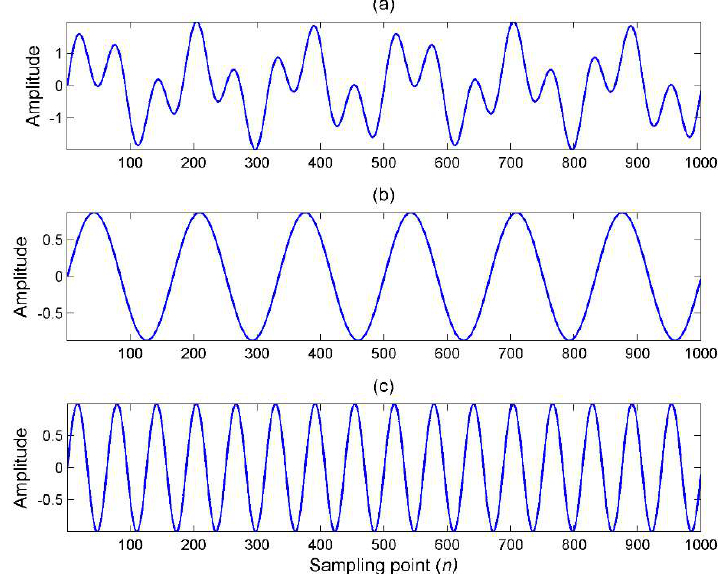
Figure 3. Decomposition of the artificially mixed signal by variational mode decomposition (VMD): ( a ) the mixed signal; ( b ) IMF1 of the signal; ( c ) IMF2 of the signal.